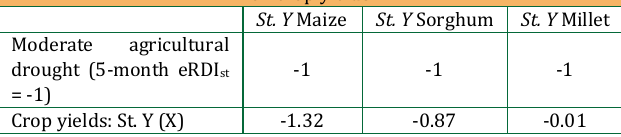
Table 6: Impact of an ephemeral and moderate agricultural drought on crop yields